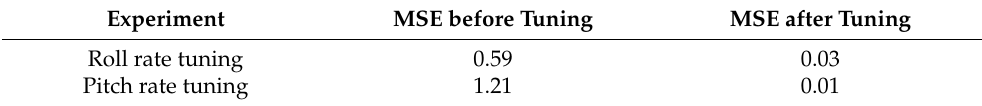
Table 1. The mean squared error (MSE) for the simulation results with the optimal learning rate, α ∗ .